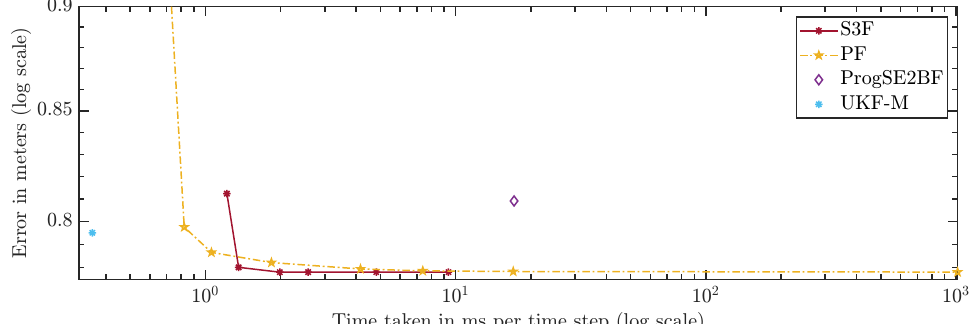
Time taken in ms per time step (log Figure 13. Position error over run